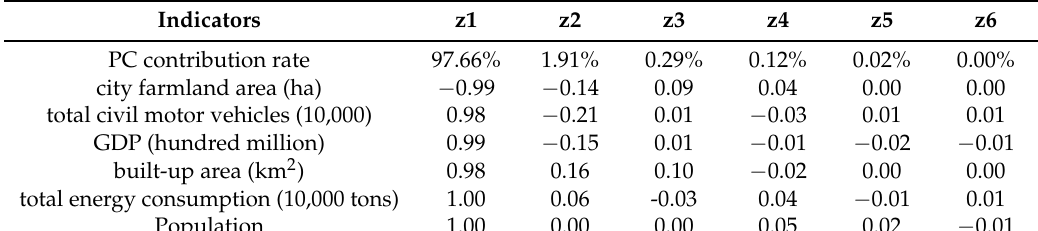
Table 3. Principal component analysis.